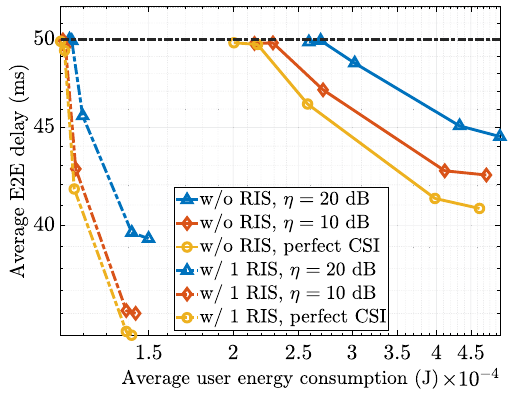
Fig. 2 Average delay versus user energy (single